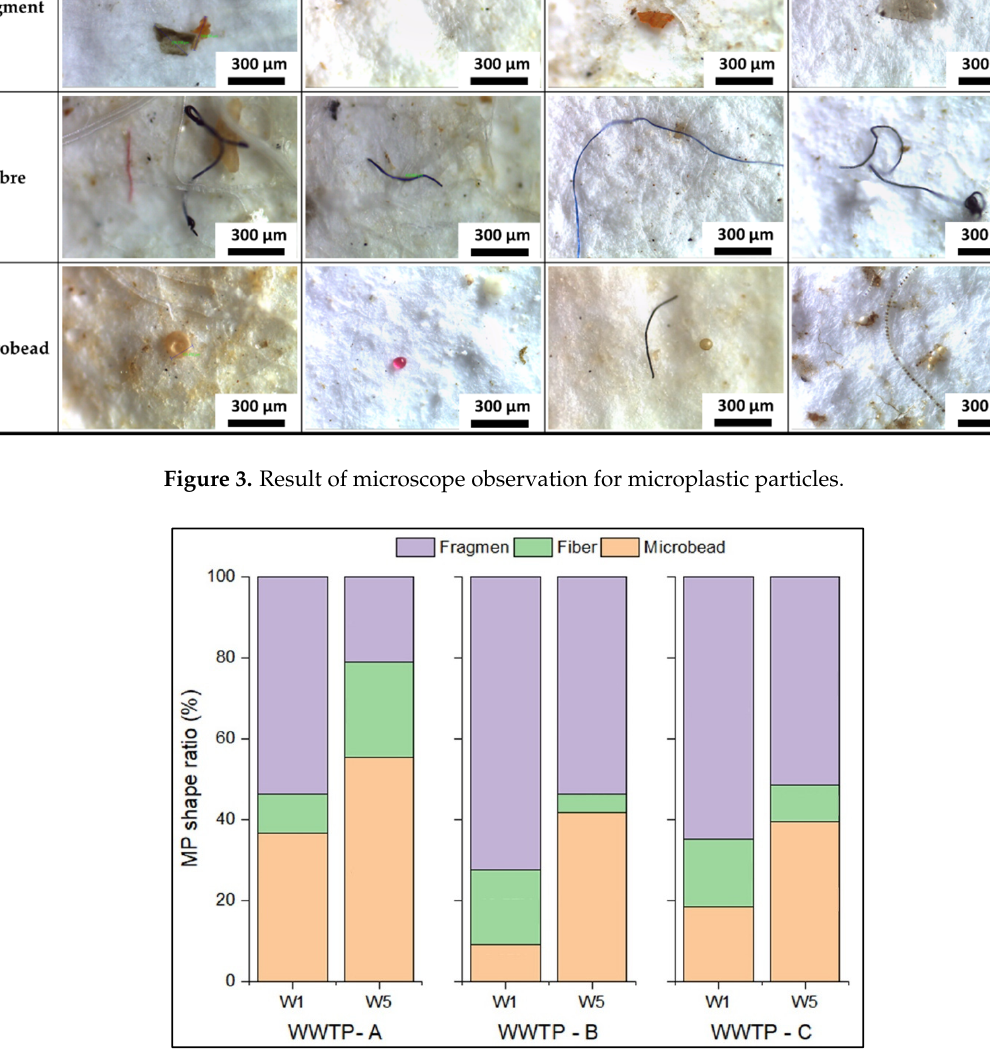
Figure 4. Comparison portion of microplastic shape between influent (W1) and effluent (W5).